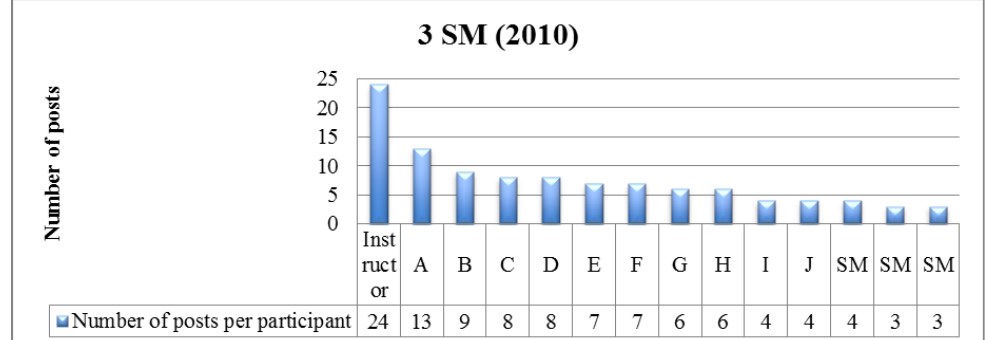
Figure 3. Number of posts per participant of 3 SM